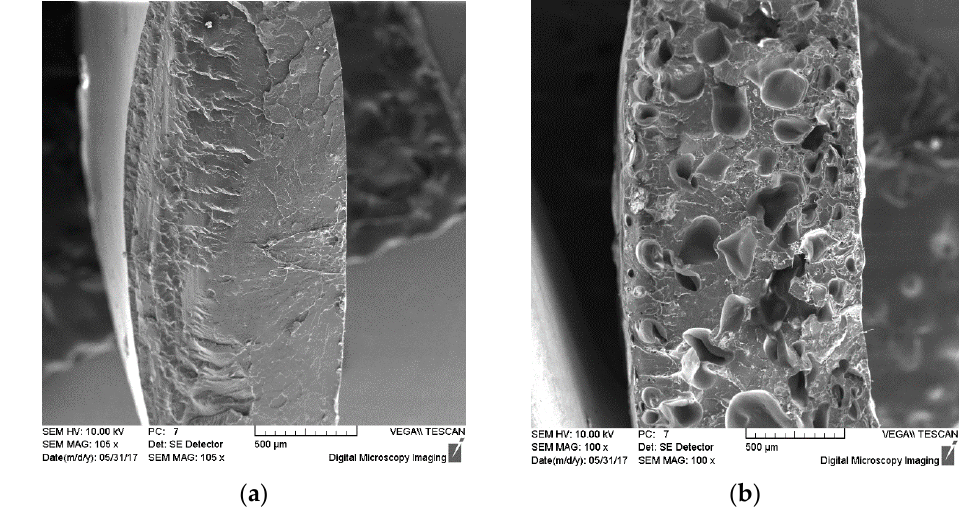
Figure 9. Scanning electron micrographs of pure compact PLA ( a ) and microporous PLA ( b ).